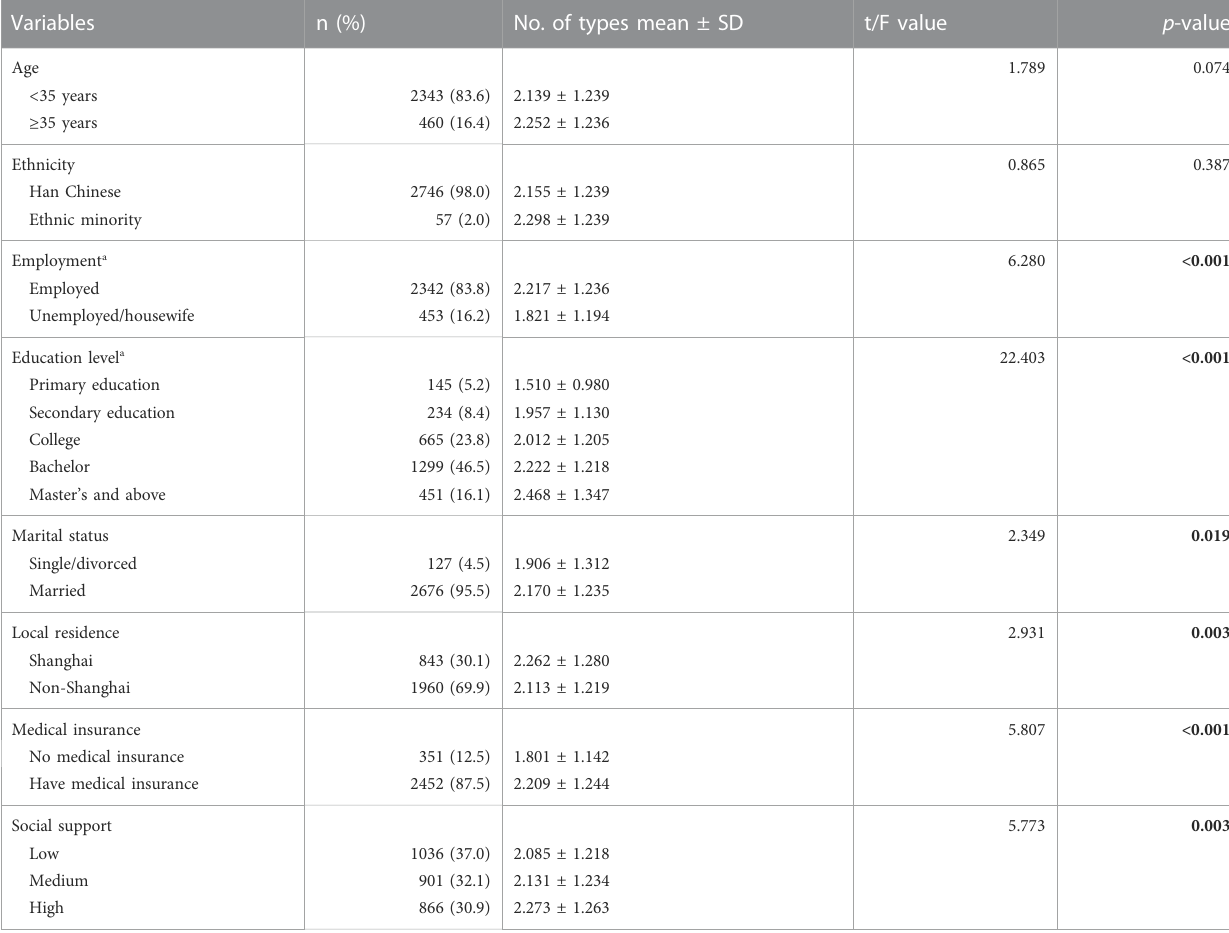
TABLE 1 Relationships in the use of different types of dietary supplements with social-demographic characteristics in pregnant women (N = 2803).